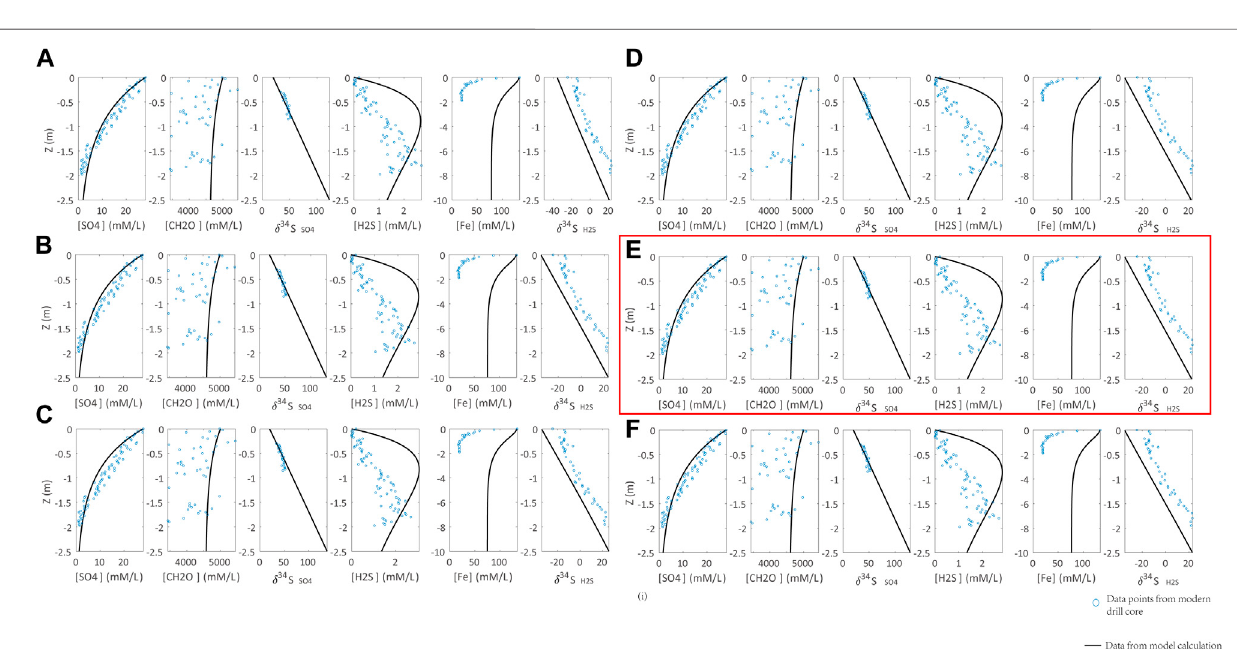
Frontiers in Earth Science |